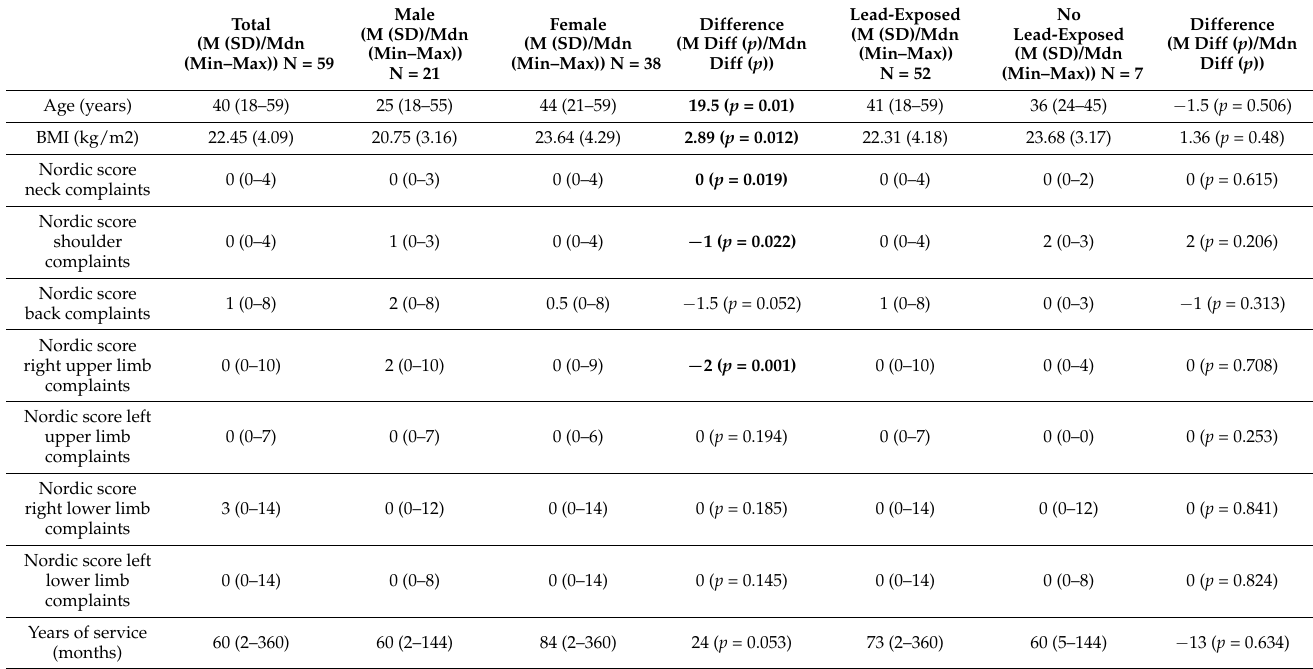
Table 1. Characteristics of